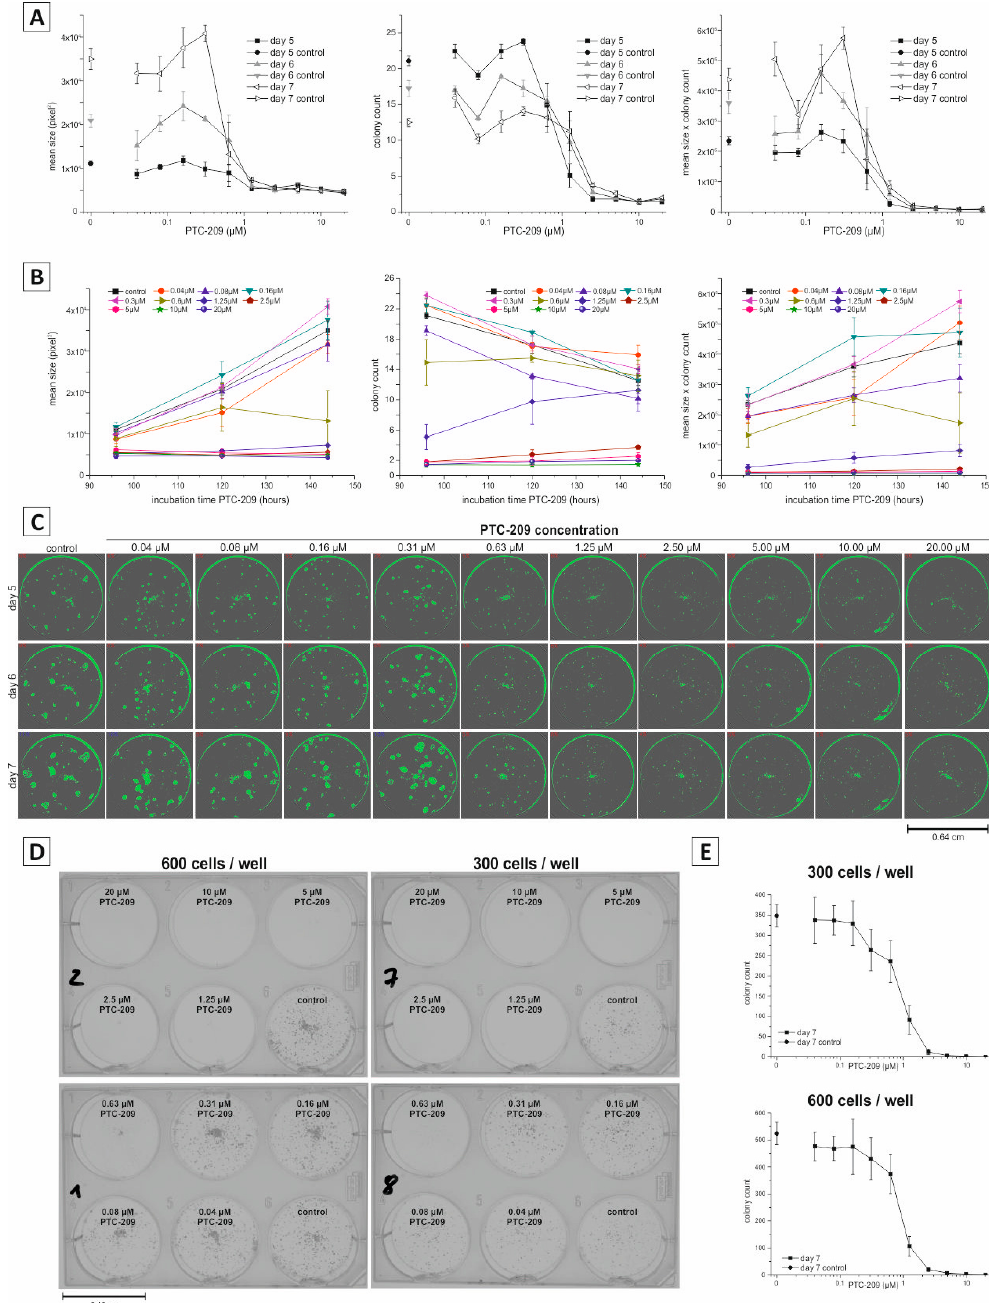
Figure 4. Evaluation of the inhibitory effect of PTC-209 on clonogenic growth in the 96-well format using non-endpoint confluence measurement. ( A ) Dose-dependent effect of PTC-209 on mean colony size, number of colonies, and the factor mean size × colony count after 5, 6, and 7 days of incubation, respectively. Data are given as mean values ± standard error of mean; ( B ) Time-resolved analysis of the effect of different PTC-209 concentrations on mean size, number of colonies, and the factor mean size × colony count. Data are given as mean values ± standard error of mean; ( C ) Representative confluence images for a complete experimental series. From left to right: dose-dependent effect of PTC-209 on clonogenic growth. From top to bottom: time-resolved effect of various PTC-209 concentrations in the same well; ( D ) Exemplary images of a clonogenic assay performed in the 6-well plate format taken with a digital camera following crystal violet staining; ( E ) Dose-dependent effect of PTC-209 on colony count after 7 days in the 6-well format. Data are given as the mean values ± standard error of mean. All data were obtained from n ≥ 3 individual experiments.